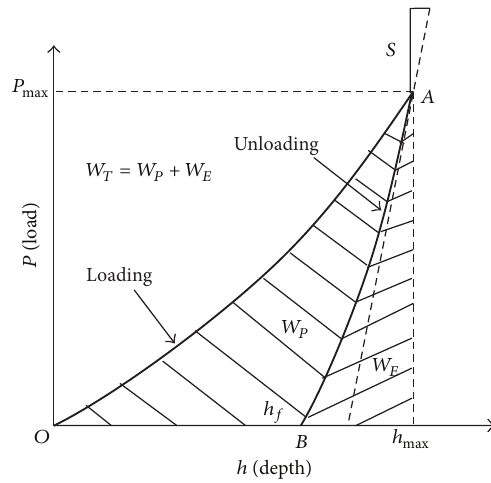
Figure 1: Typical indentation load-depth ( P - h ) curve for elastoplas- tic material.